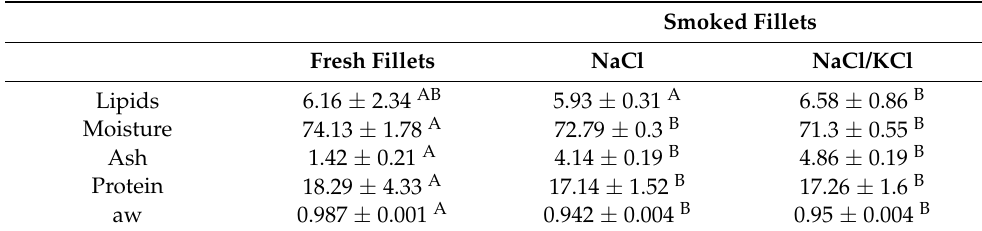
Table 2. Proximate composition in the fresh and smoked fillets of D.